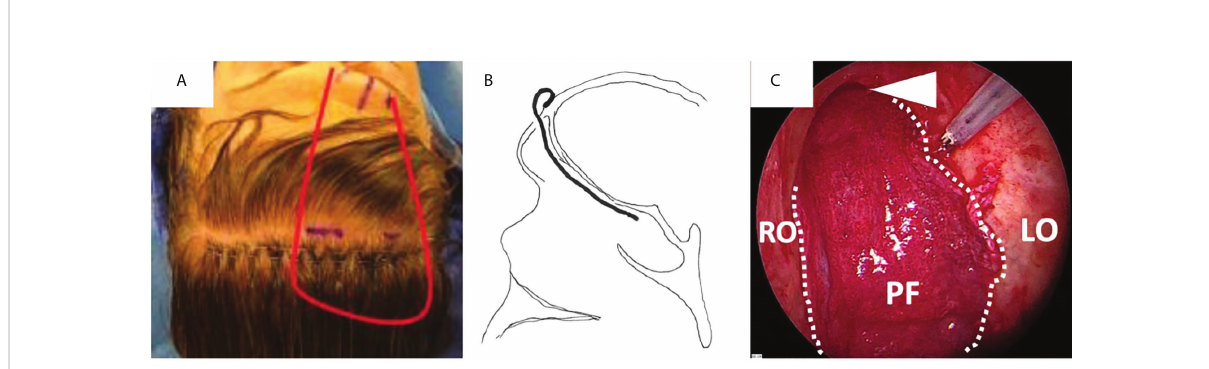
FIGURE 5 Covering of the anterior skull base with a pericranial fl ap (PF) after endoscopic transnasal craniectomy for an olfactory neuroblastoma in a previously irradiated patient. (A) Lining of the pericranial fl ap (red line) pedicled on the left supraorbital and supratrochlear pedicles. (B) The fl ap is placed against the whole anterior skull base through an opening in the superior aspect of the anterior wall of the frontal sinus. (C) Final endoscopic view, with the fl ap covering the whole anterior skull base, from the right to the left orbit (RO and LO, respectively) laterally and from the frontal sinus (white arrow head) to the sellar region